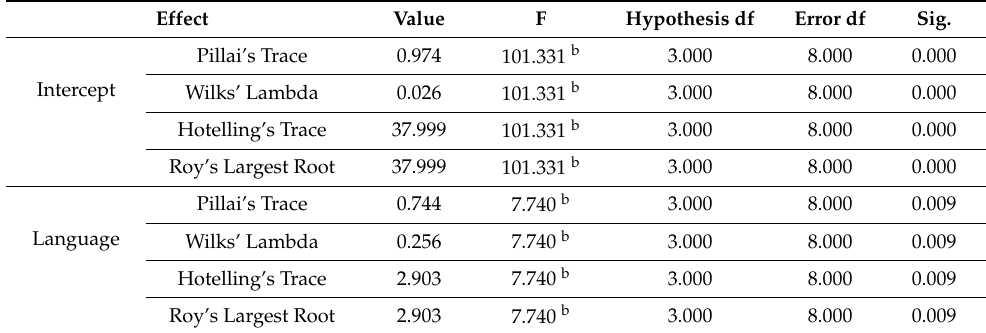
Table 2. Multivariate